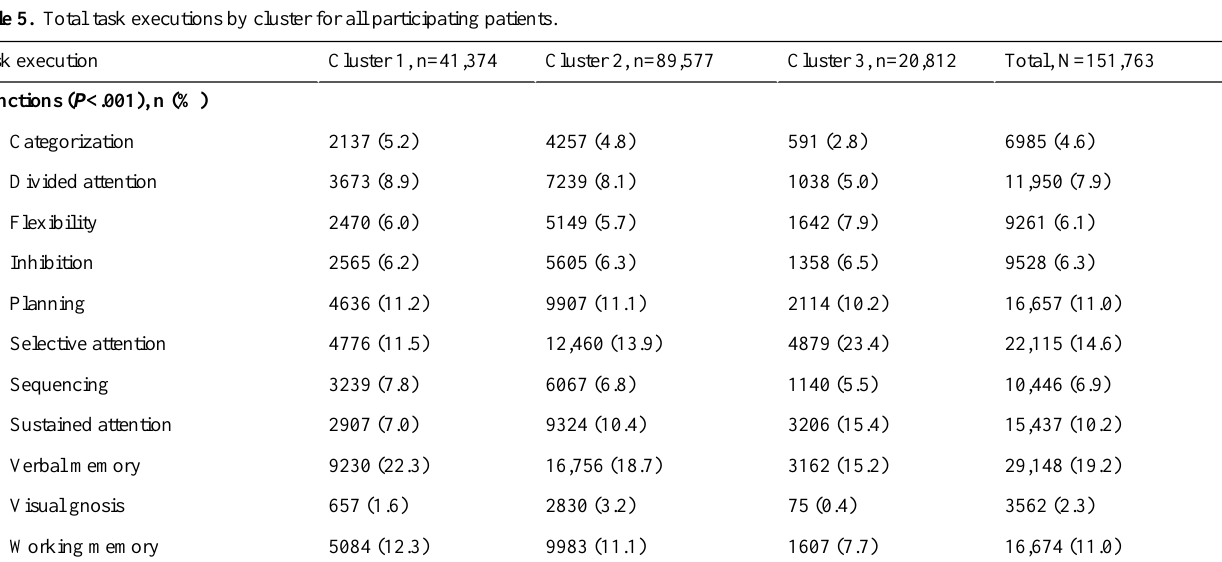
Table 5. Total task executions by cluster for all participating